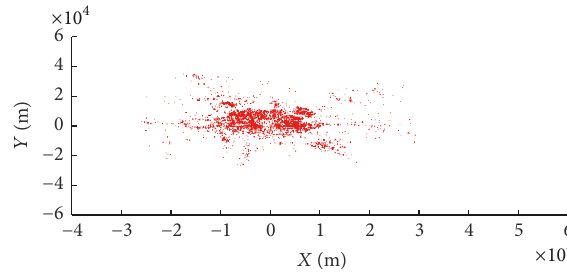
Figure 5: Scatterplot of the passenger trip